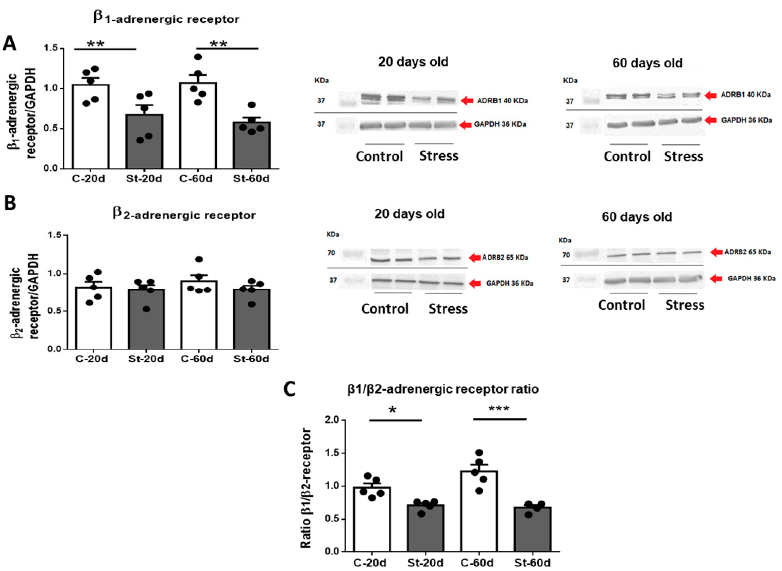
Figure 3. Western blot analysis of β 1 adrenergic receptors (Figure 3). On the left side of 3( A ), the quantification of the signal normalized by the GAPDH signal for 5 control and 5 stressed rats at 20 and 60 days old is shown. ADBR1 represents β 1 adrenergic receptor. The results are the mean ± SEM of five rats, each one in control and stressed rats. *** p < 0.001 stress vs. control. Figure 3B (left side) shows the mean ± SEM of the data for β 2 adrenergic receptor normalized by GAPDH for 5 rats in the control group and 5 in stressed rats at 20 and 60 days old. ADBR2 represents β 2 adrenergic receptor. A representative blot is shown on the right side of 3( A , B ), for all the conditions. In the lower panel ( C ), the β 1/ β 2 ratio for the samples above is shown. The results are mean ± SEM of 5 rats in each condition. * p < 0.05 stress vs. control, ** p < 0.01 stress vs. control *** p < 0.001 stress vs. control.